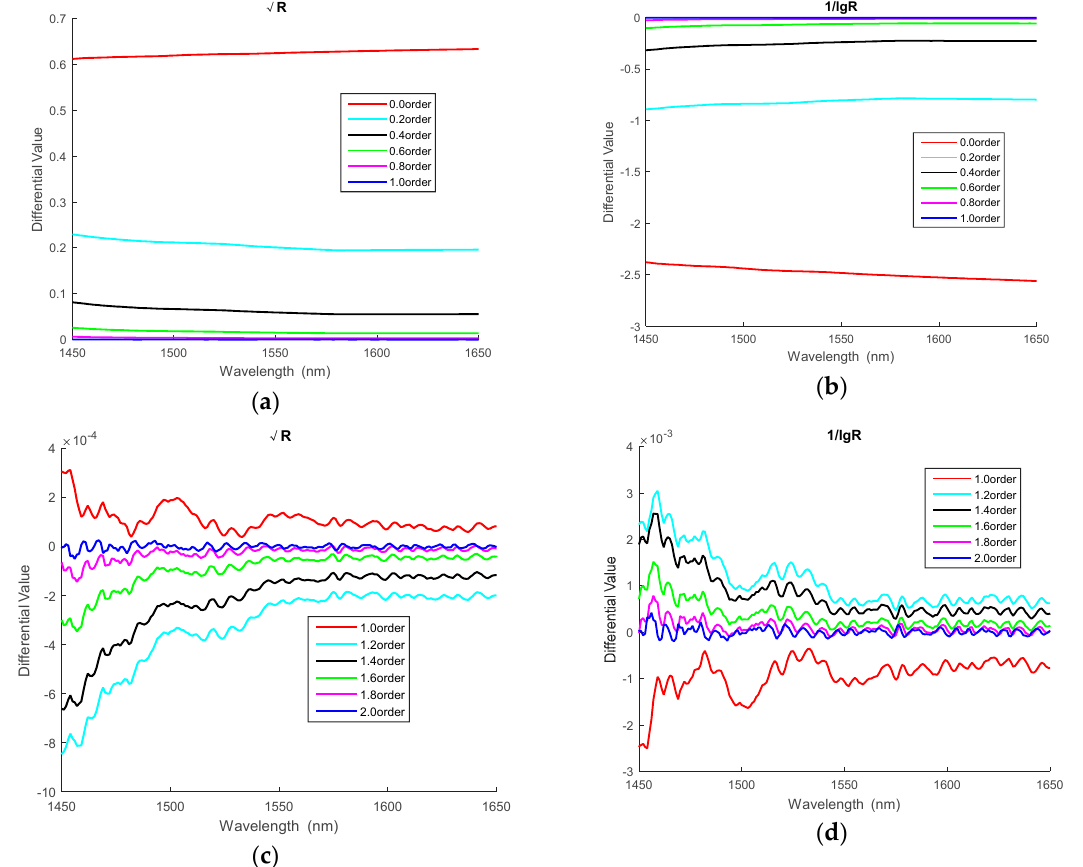
Figure 3. Fractional differential calculation of R and 1/lgR reflectance at 1450–1650 nm: ( a ) 0-order to 1-order of root mean square; ( b ) 0-order to 1-order of logarithm reciprocal; ( c ) 1-order to 2-order of root mean square; and ( d ) 1-order to 2-order of logarithm reciprocal.